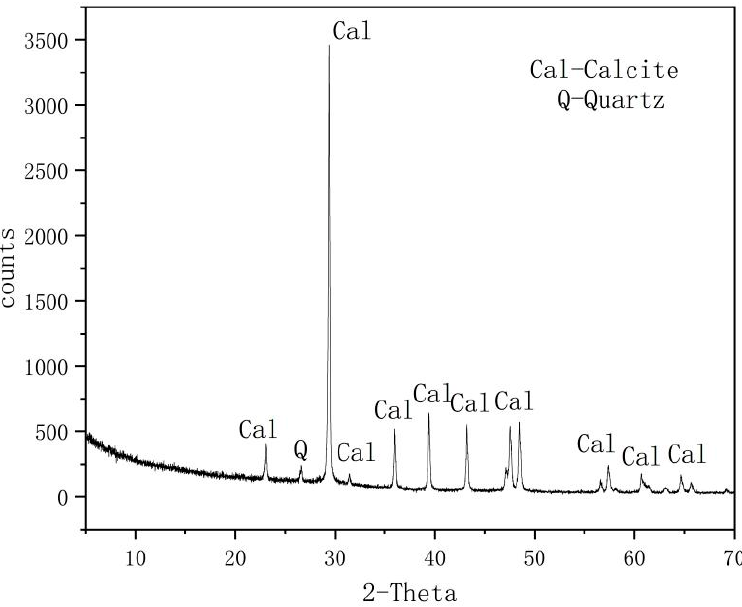
Figure 4. A supplementary figure of the X-ray diffraction whole-rock mineral analysis. Table 2. Main chemical composition content of the rock sample and LS (wt%). Chemical Components